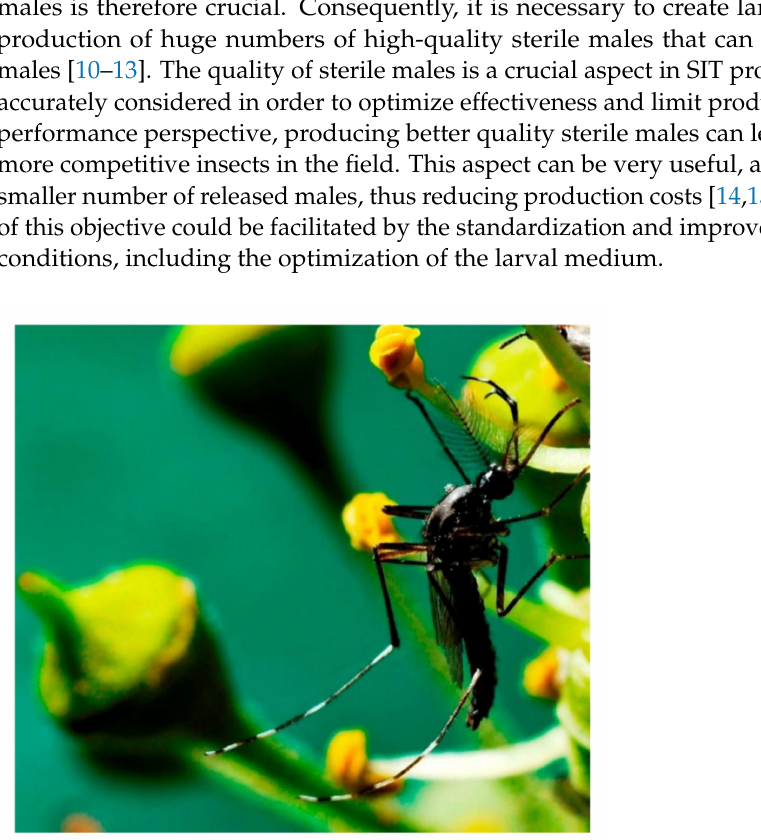
Figure 1. Adult male of Aedes albopictus